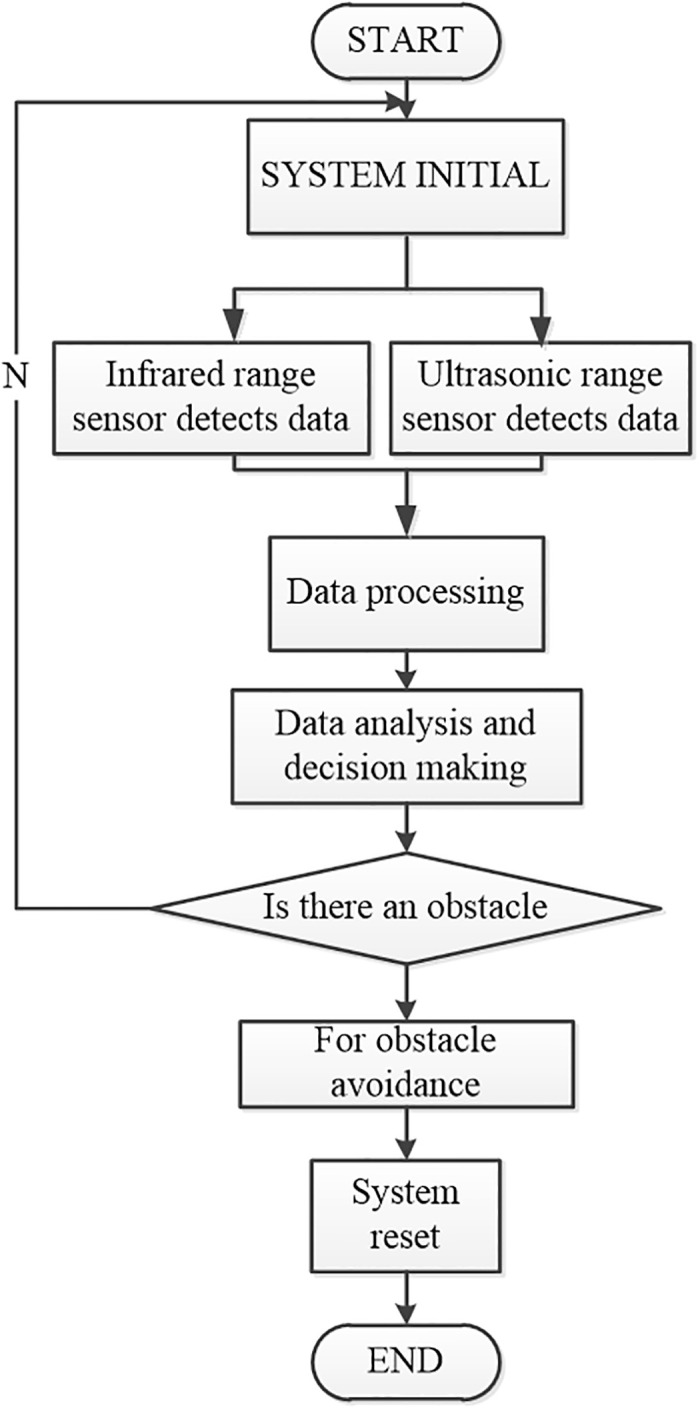
Flowchart of the robot obstacle avoidance module system.